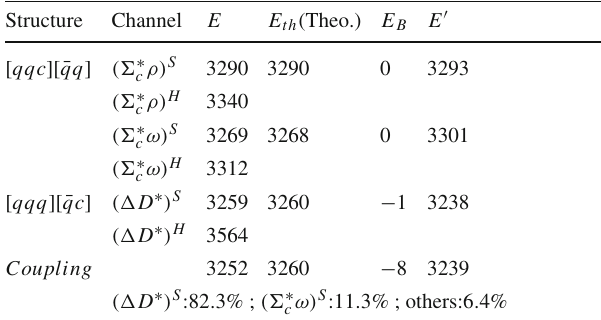
Table 15 The energies of the qqq ¯ qc pentaquark system with quantum